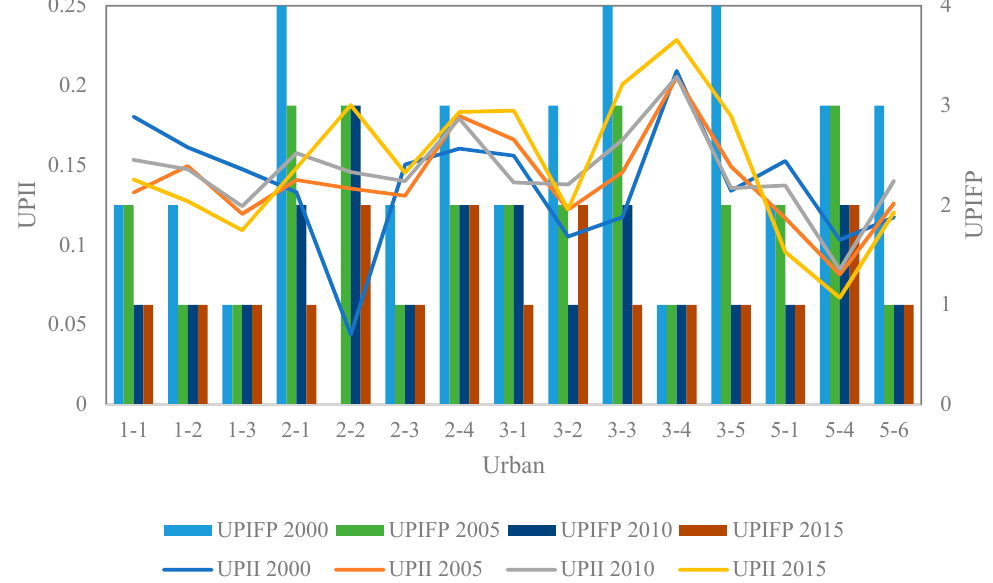
Figure 9. UPI intensity (UPII) and UPI footprint (UPIFP) in 2000, 2005, 2010, and 2015.